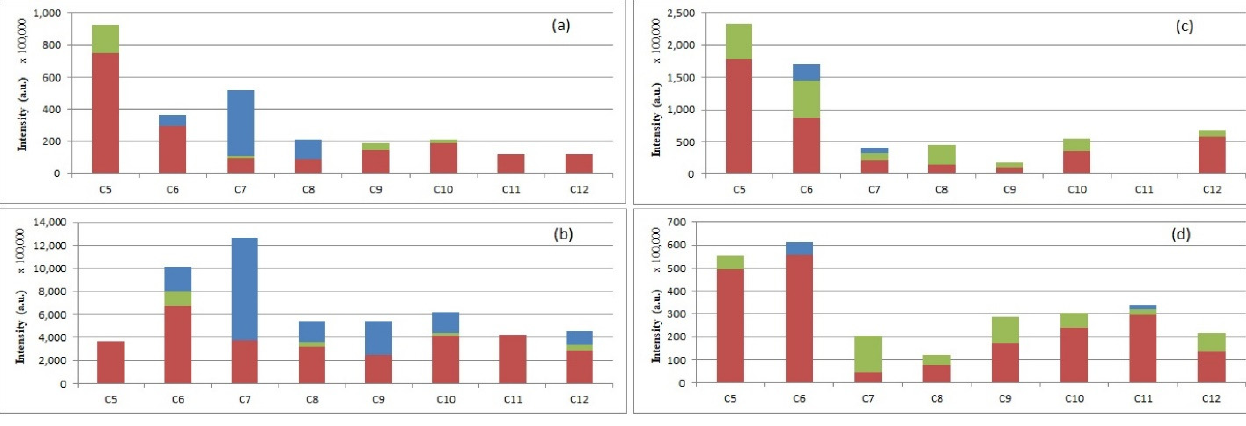
Table 4. Estimated low heating values (MJ/kg) of the C5–C12 fraction after pyrolysis at 600 °C of Desmodesmus sp. microalgae and of its n-hexane extract, in presence or absence of alumina catalyst. Sample ( Desmodesmus sp.)